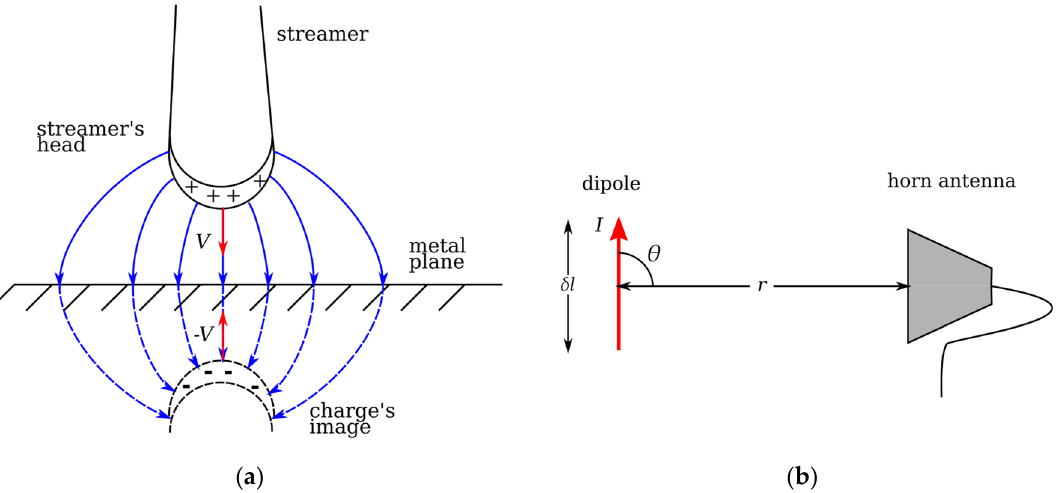
Figure 8. ( a ) Scheme of formation of transition radiation when the streamer head approaches the conducting plane with the velocity V . ( b ) Schematic layout of the horn antenna position with respect to the radiating electric dipole with the current I and the length δ l .